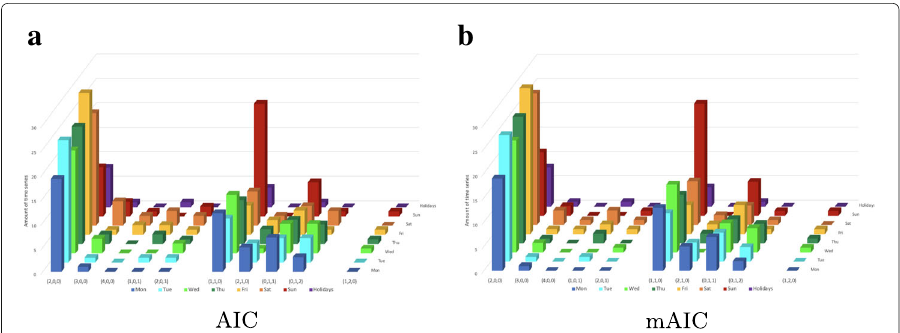
Fig. 10 Amount of time series per cluster per weekday 2016. a AIC. b